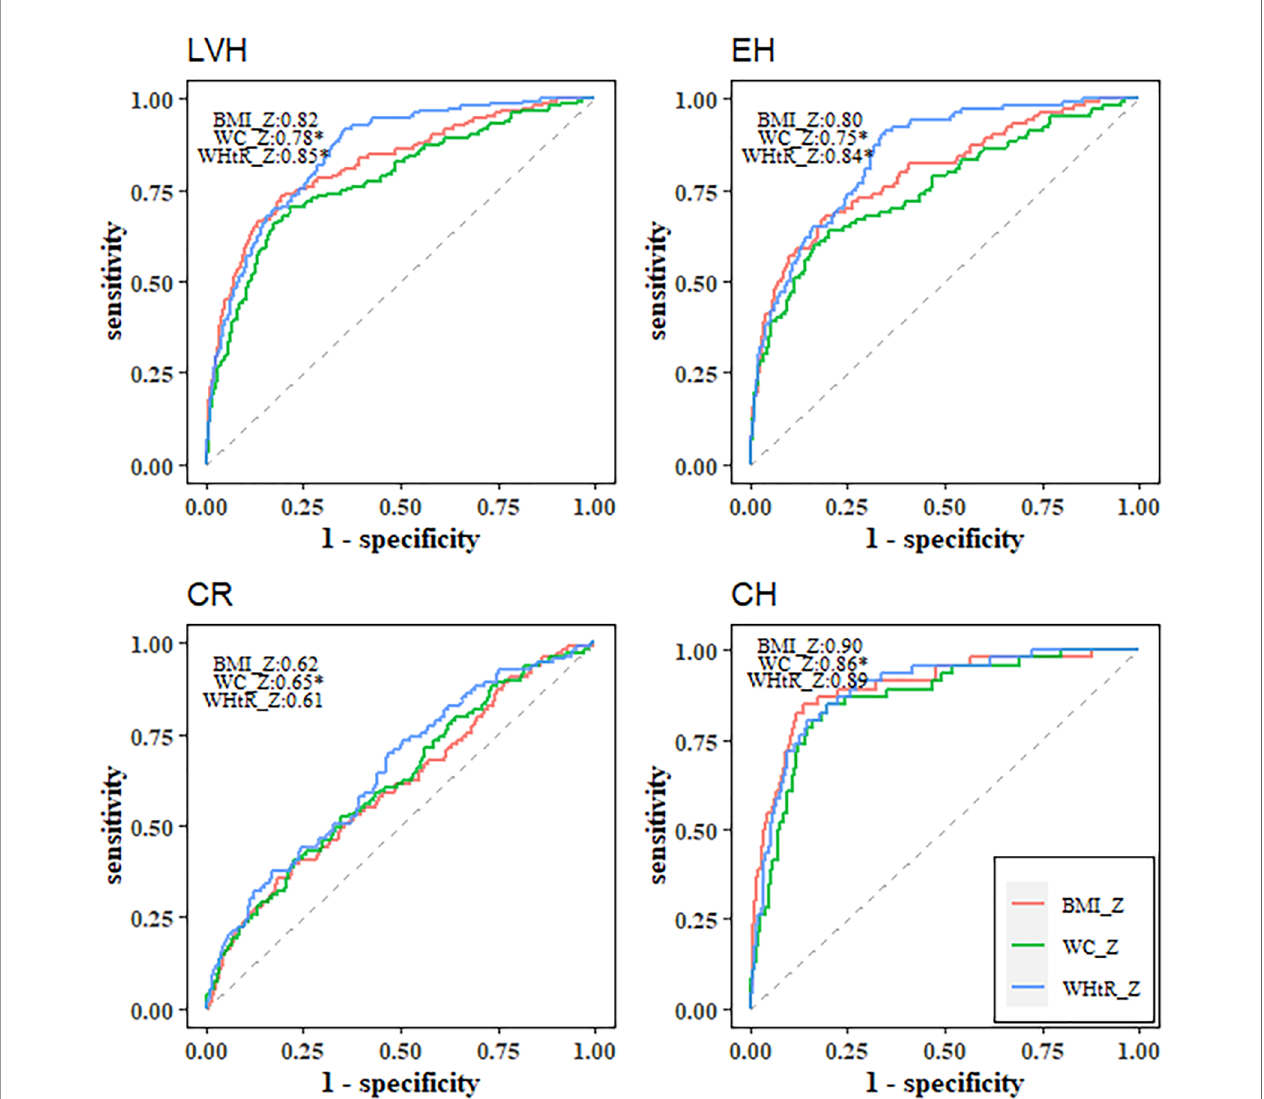
FIGURE 2 | Receiver operating characteristic curves of BMI Z-score, WC Z-score and WHtR Z-score for identifying left ventricular hypertrophy and left ventricular geometric remodeling. *Statistically signi fi cant difference in area under the operating characteristic curves as compared with BMI Z-score. LVH, left ventricular hypertrophy; CR, concentric remodeling; EH, eccentric hypertrophy; CH, concentric hypertrophy; BMI, body mass index; WC, waist circumference; WHtR, waist-to-height